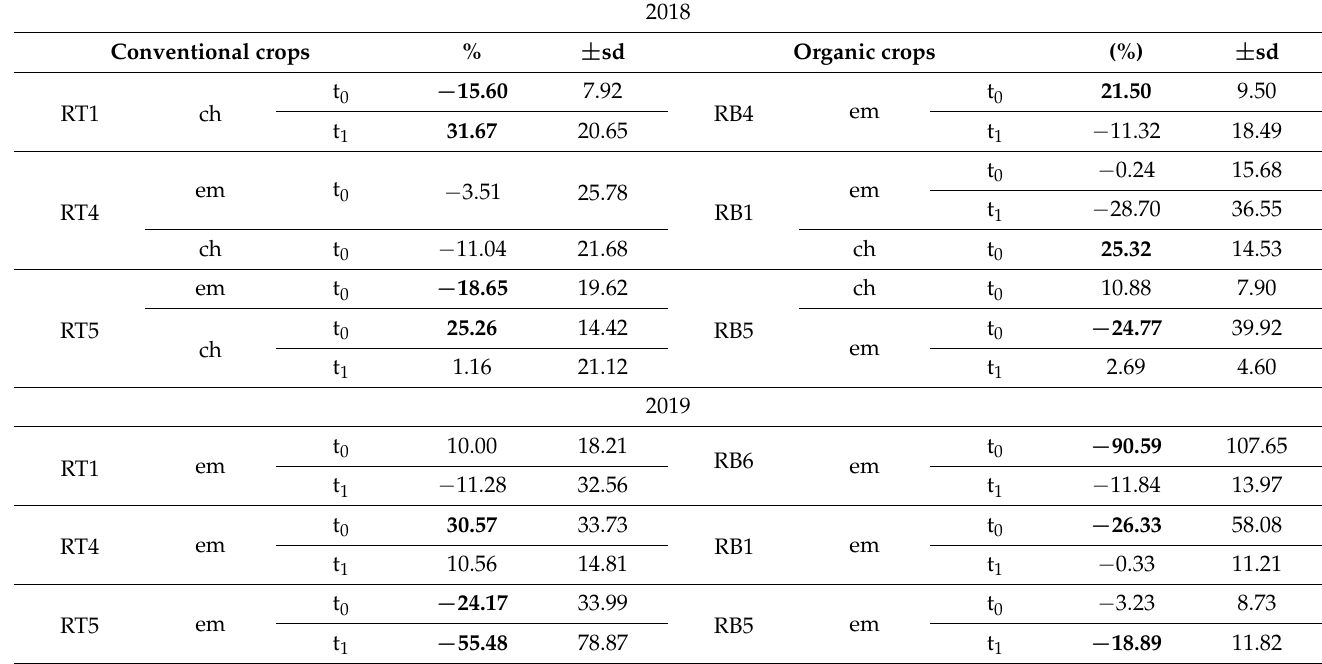
Table 5. Results of bioassays with Aliivibrio fischeri on samples of soil eluate collected during cam- paigns t 0 and t 1 (in bold are shown the effects above the toxicity threshold). Negative sign indicates biostimulation in comparison to control (Ch = rise chamber; em =